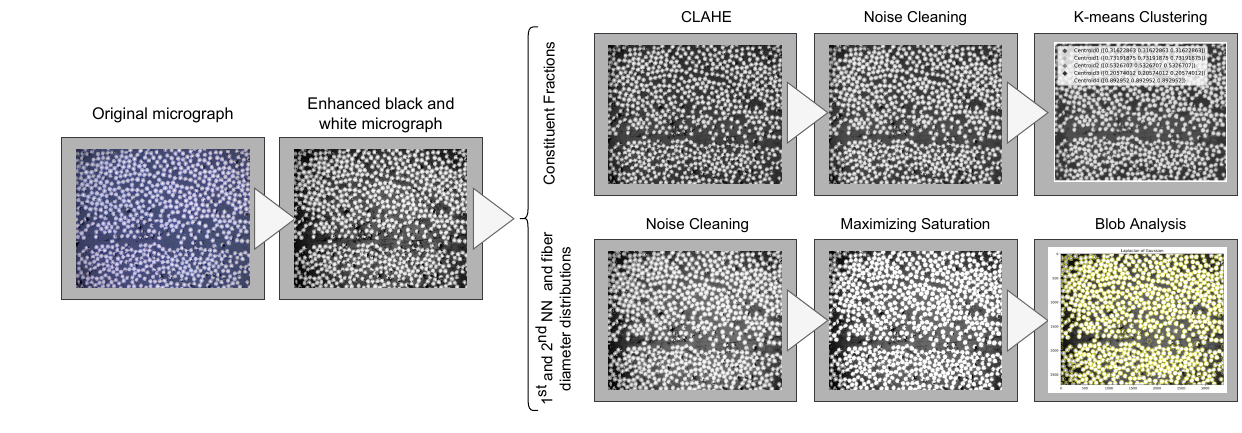
Figure 2. The imaging process